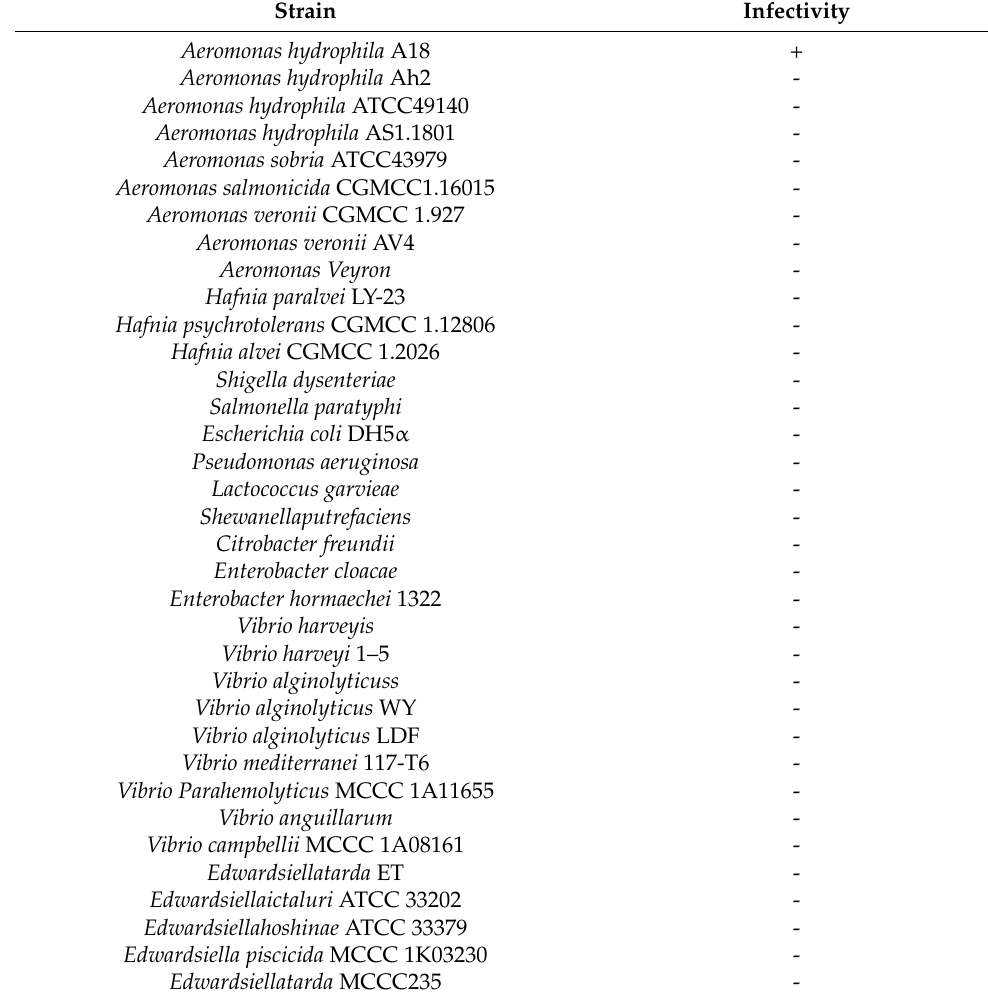
Table 1. Host range of Aeromonas phage